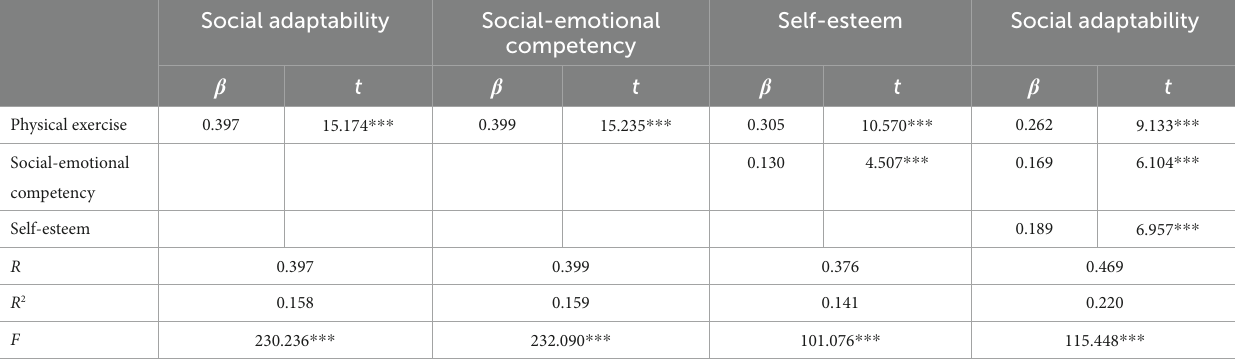
TABLE 2 Analysis of regression relationship of variables.